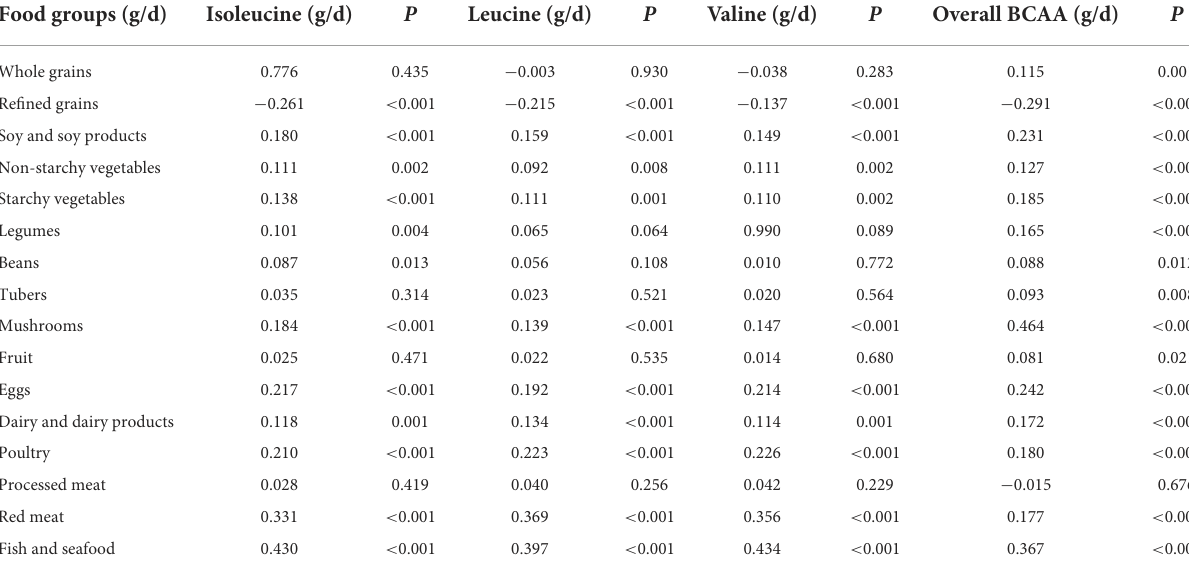
TABLE 5 Spearman’s correlation coefficients between dietary BCAA and protein intake adherence to food groups among 838 participants. Food groups